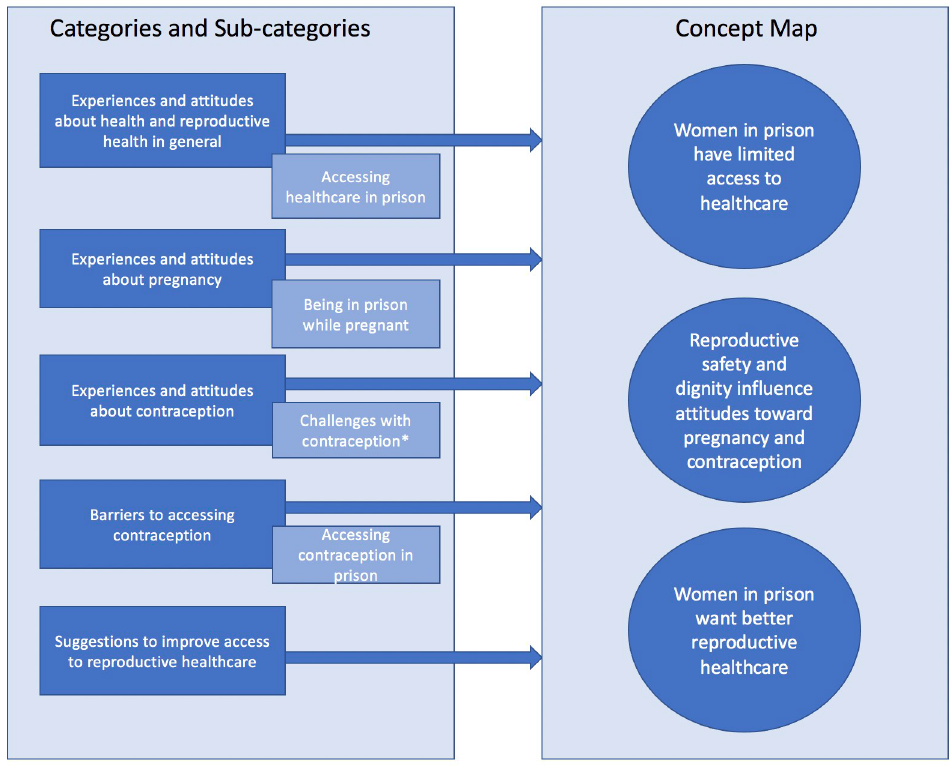
Fig 1. Summary of categories and reproductive justice concept map. Categories derived from the focus group guide, sub-categories derived inductively and concept map interpreted using a reproductive justice framework. � Sub-category ‘challenges with contraception’ was not included in our final analysis in order to streamline results, as the relevant concepts within this sub-category were captured within the other categories.